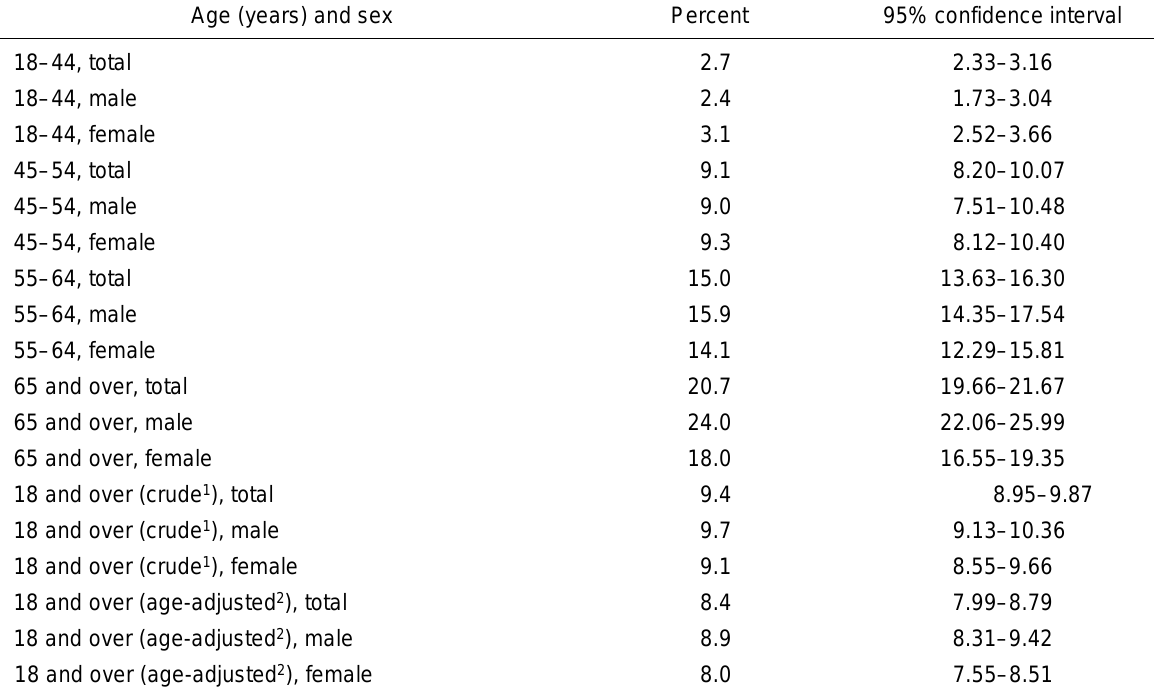
Data table for Figure 14.2. Prevalence of diagnosed diabetes among adults aged 18 and over, by age group and sex: United States, 2016